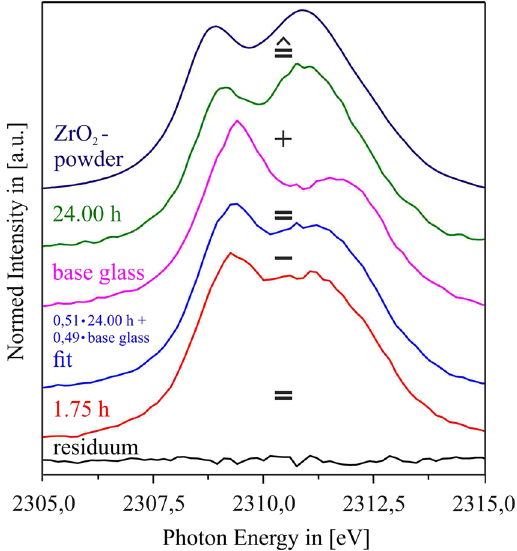
Figure 9. Schematic illustration of the linear combination of a weighted Zr L 2 spectrum of the sample thermally treated at t = 24 h at 725 °C (representative for [8] Zr 4 + in fully crystalline environment) with that of a weighted Zr L 2 spectrum of the green glass sample (representative for [6] Zr 4 + in fully amorphous environment) to gain a best fit of the recorded Zr L 2 spectra of all time steps between green glass and t = 24 h (shown here: the best fit of the Zr L